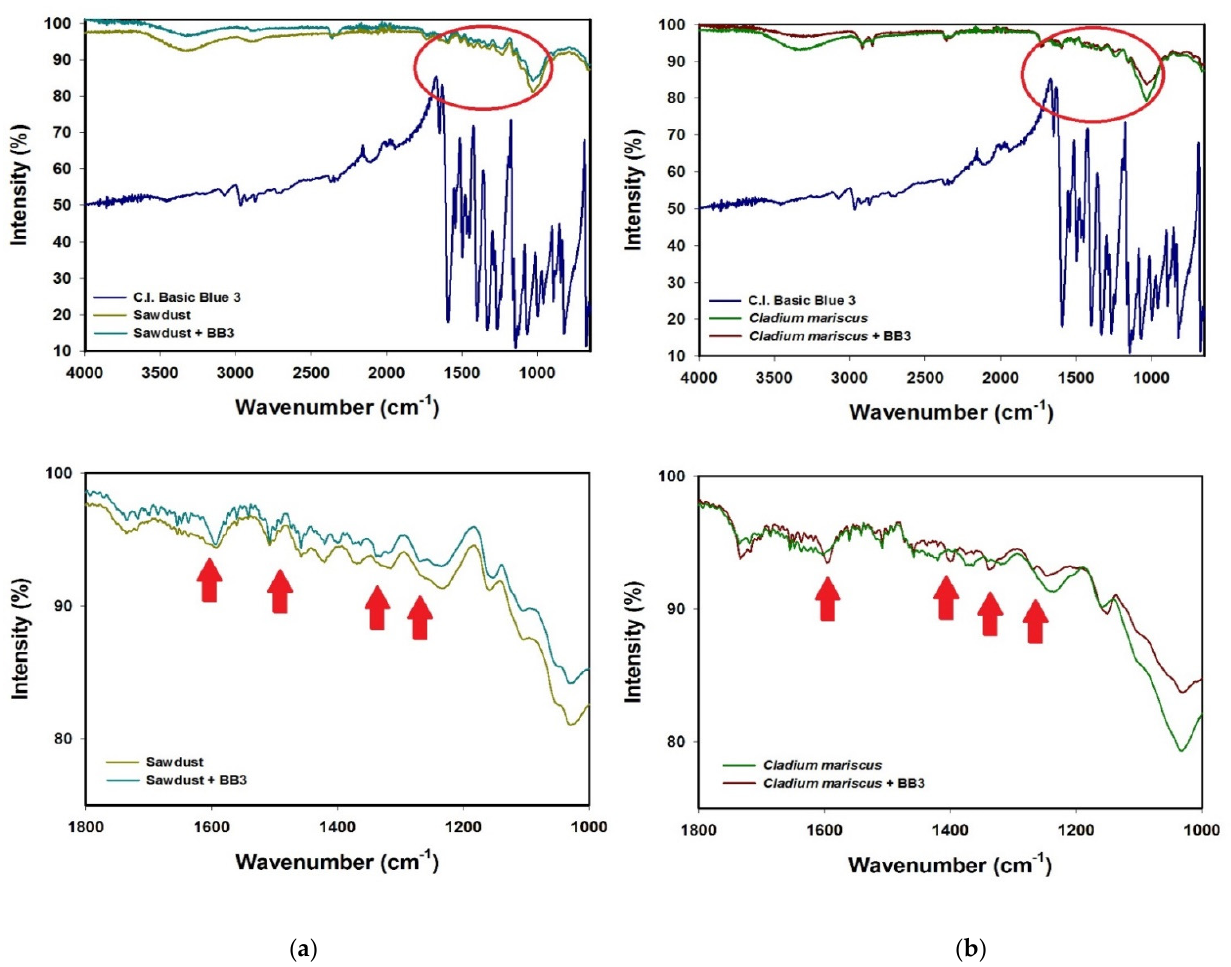
Figure 10. The FTIR spectra of BB3 and biosorbents before and after dye adsorption: ( a ) sawdust and ( b ) Cladium mariscus saw-sedge.